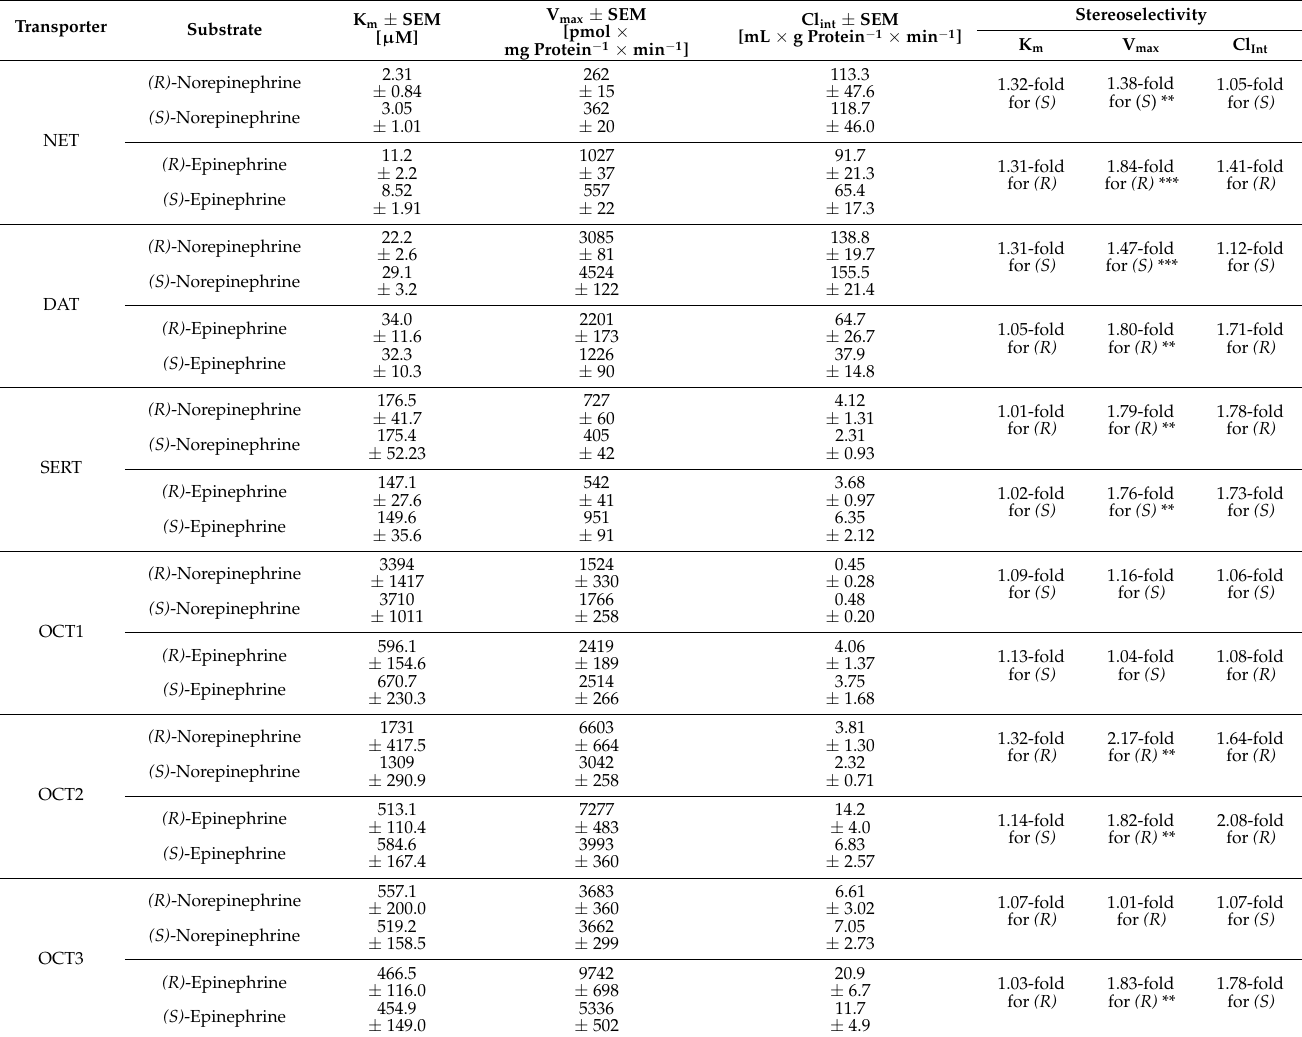
Table 1. Transport kinetic parameters (K m , apparent affinity; v max , maximum transport capacity; Cl int , intrinsic clearance) of norepinephrine and epinephrine enantiomers by MATs and